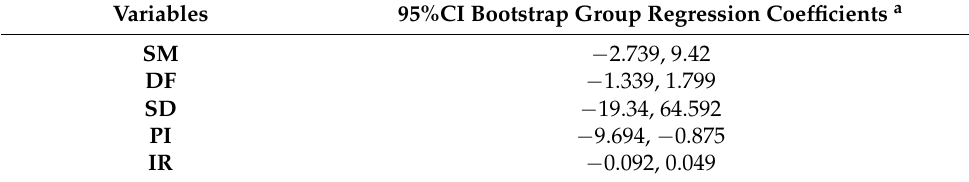
Table 6. Bootstrap mixed linear model.